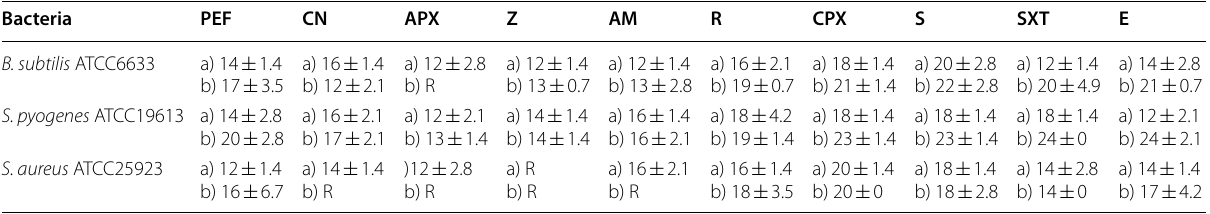
Table 6 Antibiotics susceptibility profile for selected Gram‑positive bacteria as read in mean diameter of zones of inhibition (mm) after treatment to electromagnetic flux at 15 mT intensity compared with